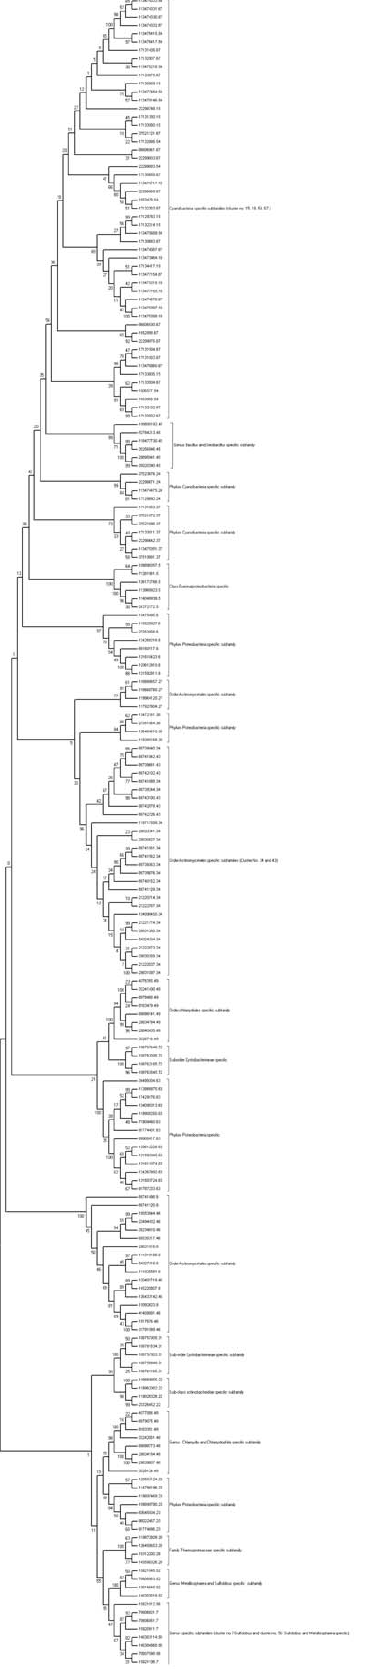
Figure 1. Dendrogram representation of prokaryotic protein kinase catalytic domains which are specific to certain taxo- nomic levels. Bootstrap values are provided at the main branches. Each protein kinase is represented as GI number and serial number of that particular cluster after dot. Taxonomic specificity of cluster is written at right hand side. For example, 120553124.23 represents GI number 120553124, it belongs to cluster number 23, which is a phylum Proteobacteria specific cluster and bootstrap value for the branch which encompasses this cluster is 99.